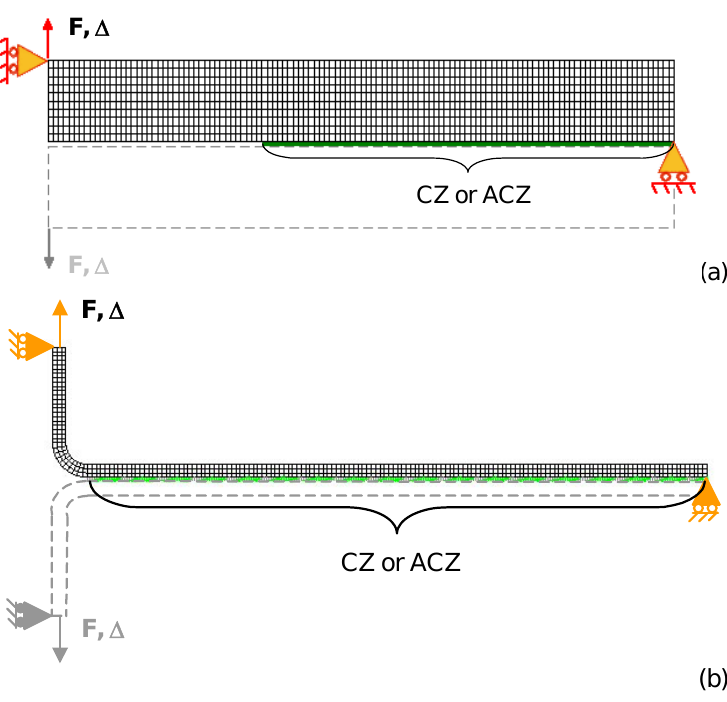
Figure 3: FE model of the DCB (a) and of the T-peel (b) joints.